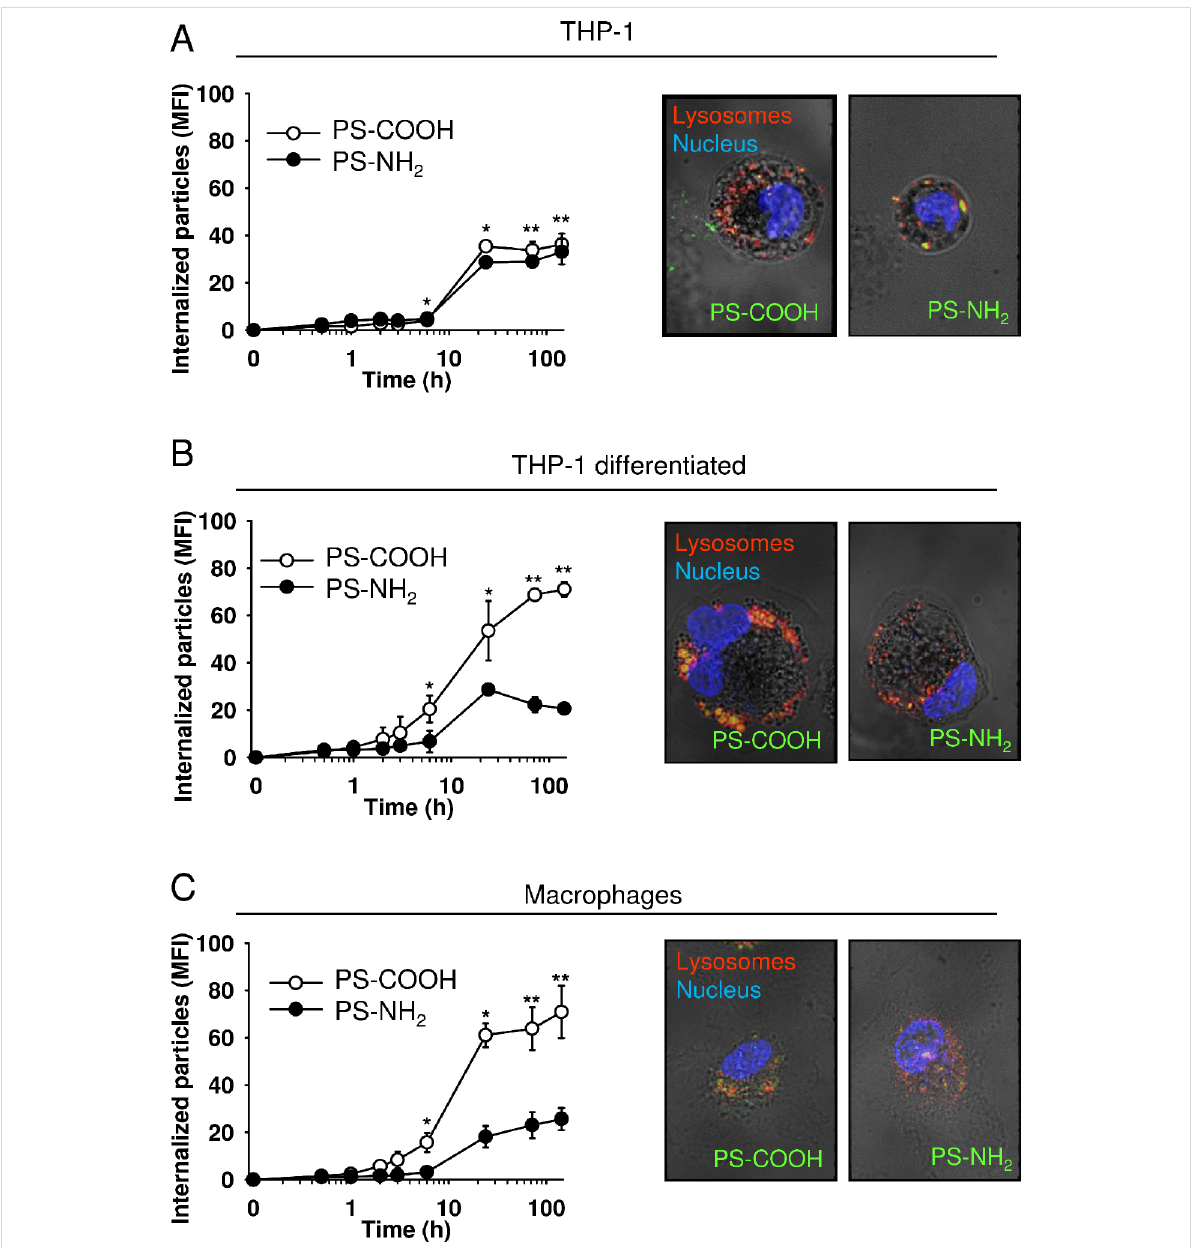
Figure 3: Uptake kinetics and subcellular localization of carboxyl- and amino-functionalized polystyrene nanoparticles by THP-1 (A), differentiated THP-1 cells (B), and human macrophages (C). The cells were incubated with PS-COOH or PS-NH 2 nanoparticles (each 100 µg/mL) and analyzed by flow cytometry or confocal microscopy (24 h). Results are given as mean ± SEM, n = 3, * p < 0.05, ** p < 0.01. Nuclei are labeled with HCS Nuclear- Mask™ (blue), nanoparticles are stained with PMI (green), lysosomes are labeled with LysoTracker® Red DND-99 (red). Original magnification 900×. Photomicrographs show overlay with phase contrast images. Adapted with permission from [41]. Copyright 2014